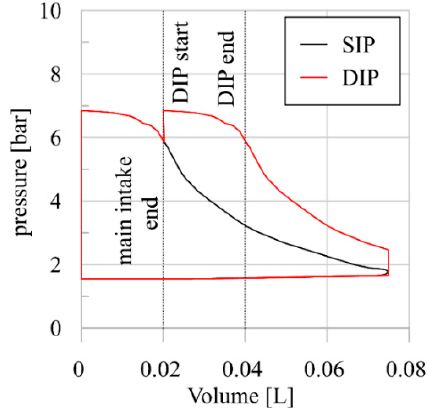
Figure 8. Dual-intake-port technology concept [31].